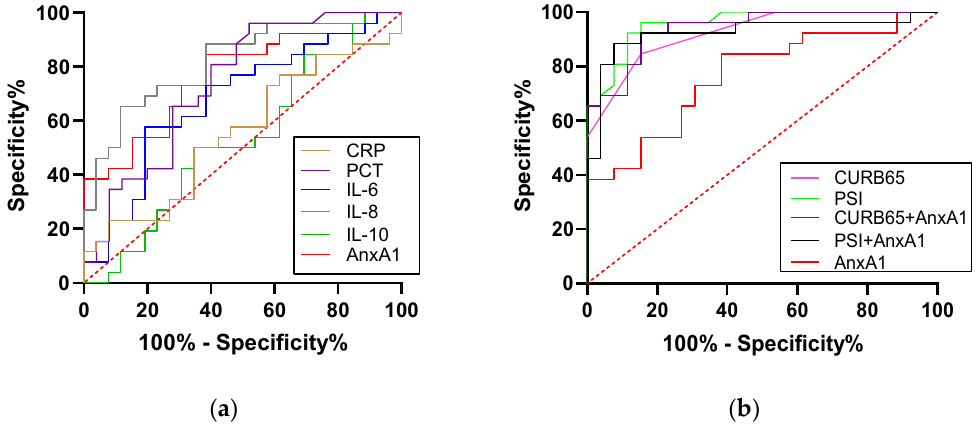
Figure 4. ROC curve analysis of the discriminatory capacity of AnxA1 level in CAP patient subsets. ( a , b ) ROC curve analysis of the capacity of AnxA1 and clinical indicators ( a ) and AnxA1 in combination with PSI or CURB-65 score ( b ) to discriminate between patients with SCAP and those with CAP. Table 4. Area under the curve and thresholds for predicting patients with SCAP.